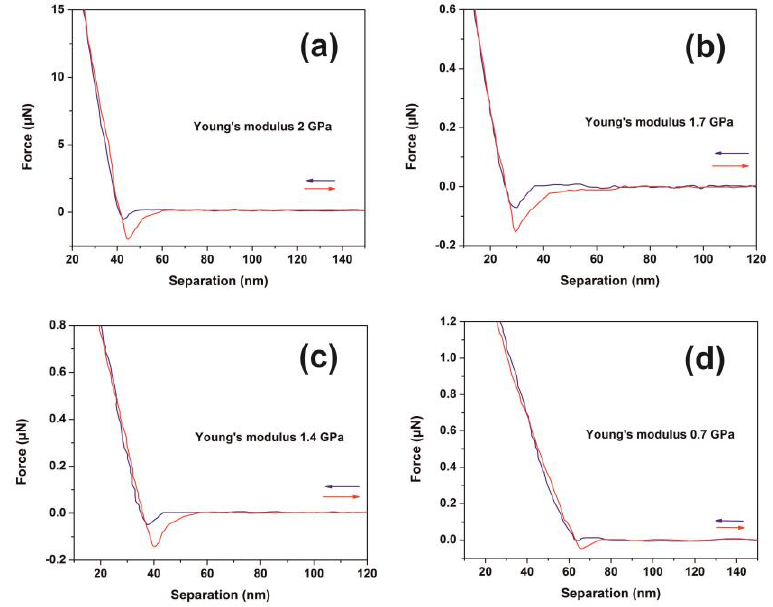
Figure 6. Typical force-distance (F-D) curves of polyacrylamide (PAM) thin layer surfaces (426 nm) irradiated with a different number of laser pulses (lp) (250 J m −2 per laser pulse): ( a ) F-D curves of the non-irradiated layer; ( b ) F-D curves with 200 lp; ( c ) F-D curves with 300 lp; ( d ) F-D curves with 400 lp.